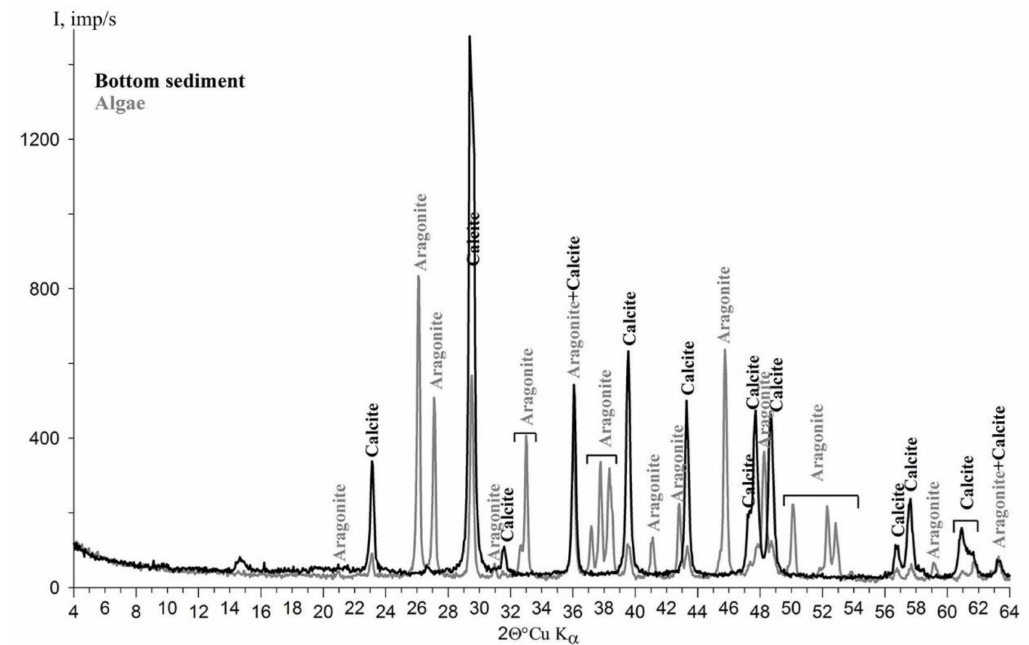
Figure 5. Di ff ractograms of Lake Linevo carbonate minerals (Kyshtovskaya system, Vasyugan plain) formed on geochemical barriers: Water–bottom sediments (black color) and submerged biota–water (gray